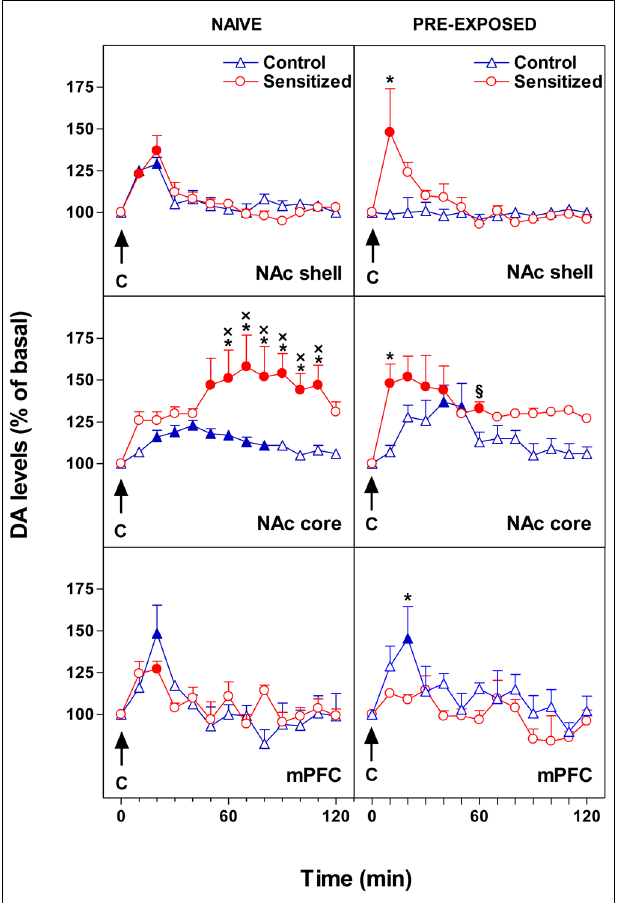
FIGURE 1 | Effect of 24-h pre-exposure to chocolate (C, 1 ml/5 min, i.o.) on NAc shell and core and mPFC dialysate DA in morphine sensitized or control rats. Results are indicated as mean ± SEM of change in DA extracellular levels expressed as the percentage of basal values. Solid symbol, p < 0.05 vs basal value; *, p < 0.05 vs Control; x , p < 0.05 vs shell naive Sensitized; §, p < 0.05 vs shell pre-exposed Sensitized. (Adapted from Figures 2 and 3; De Luca etal.,